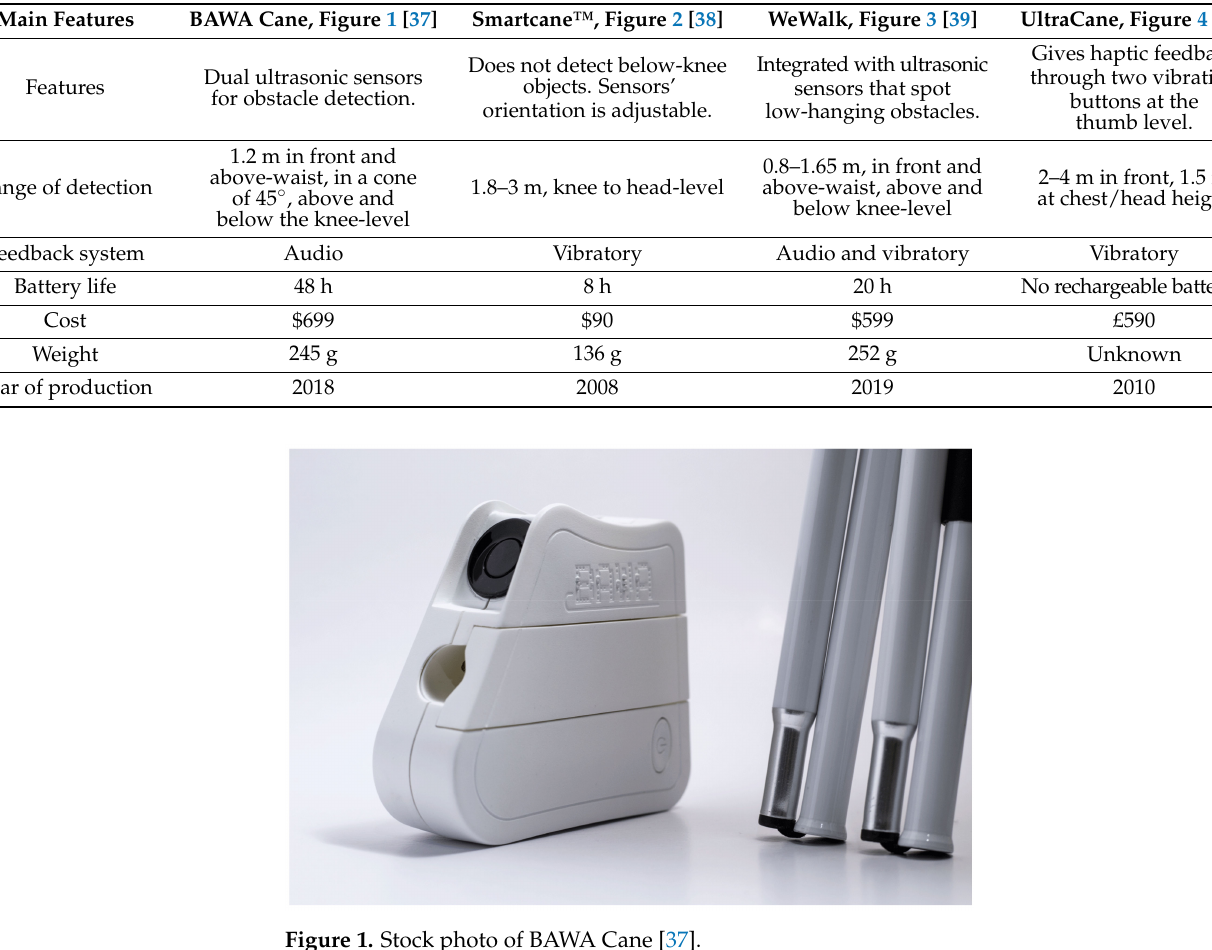
Table 6. Smart canes benchmarking.